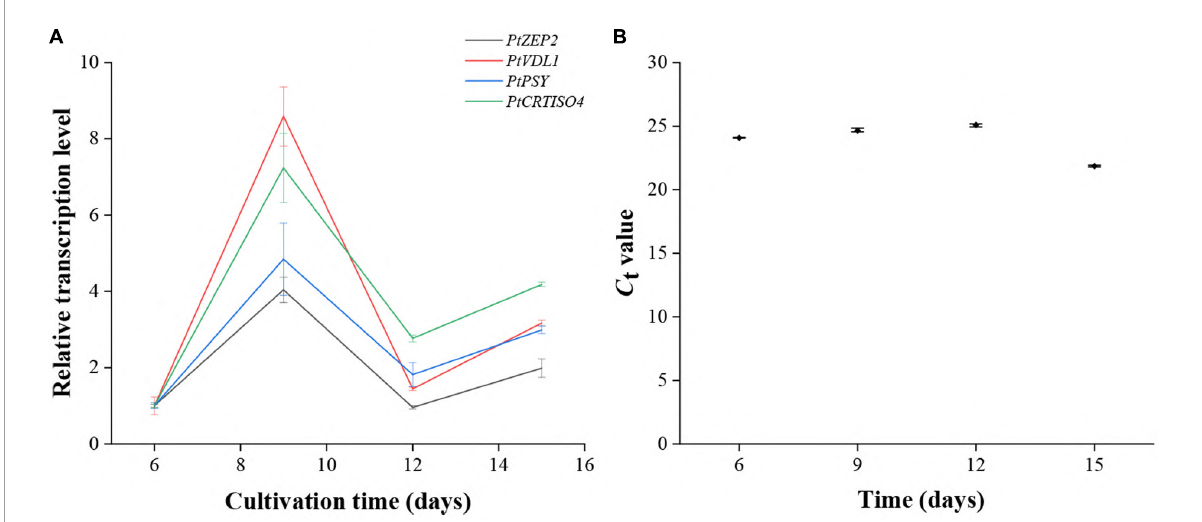
FIGURE2 Expression patterns of five genes under different cultivation stages. (A) The transcriptional pattern of PtCRTISO4 was quite similar to other three genes. (B) C t -values of CdkA .